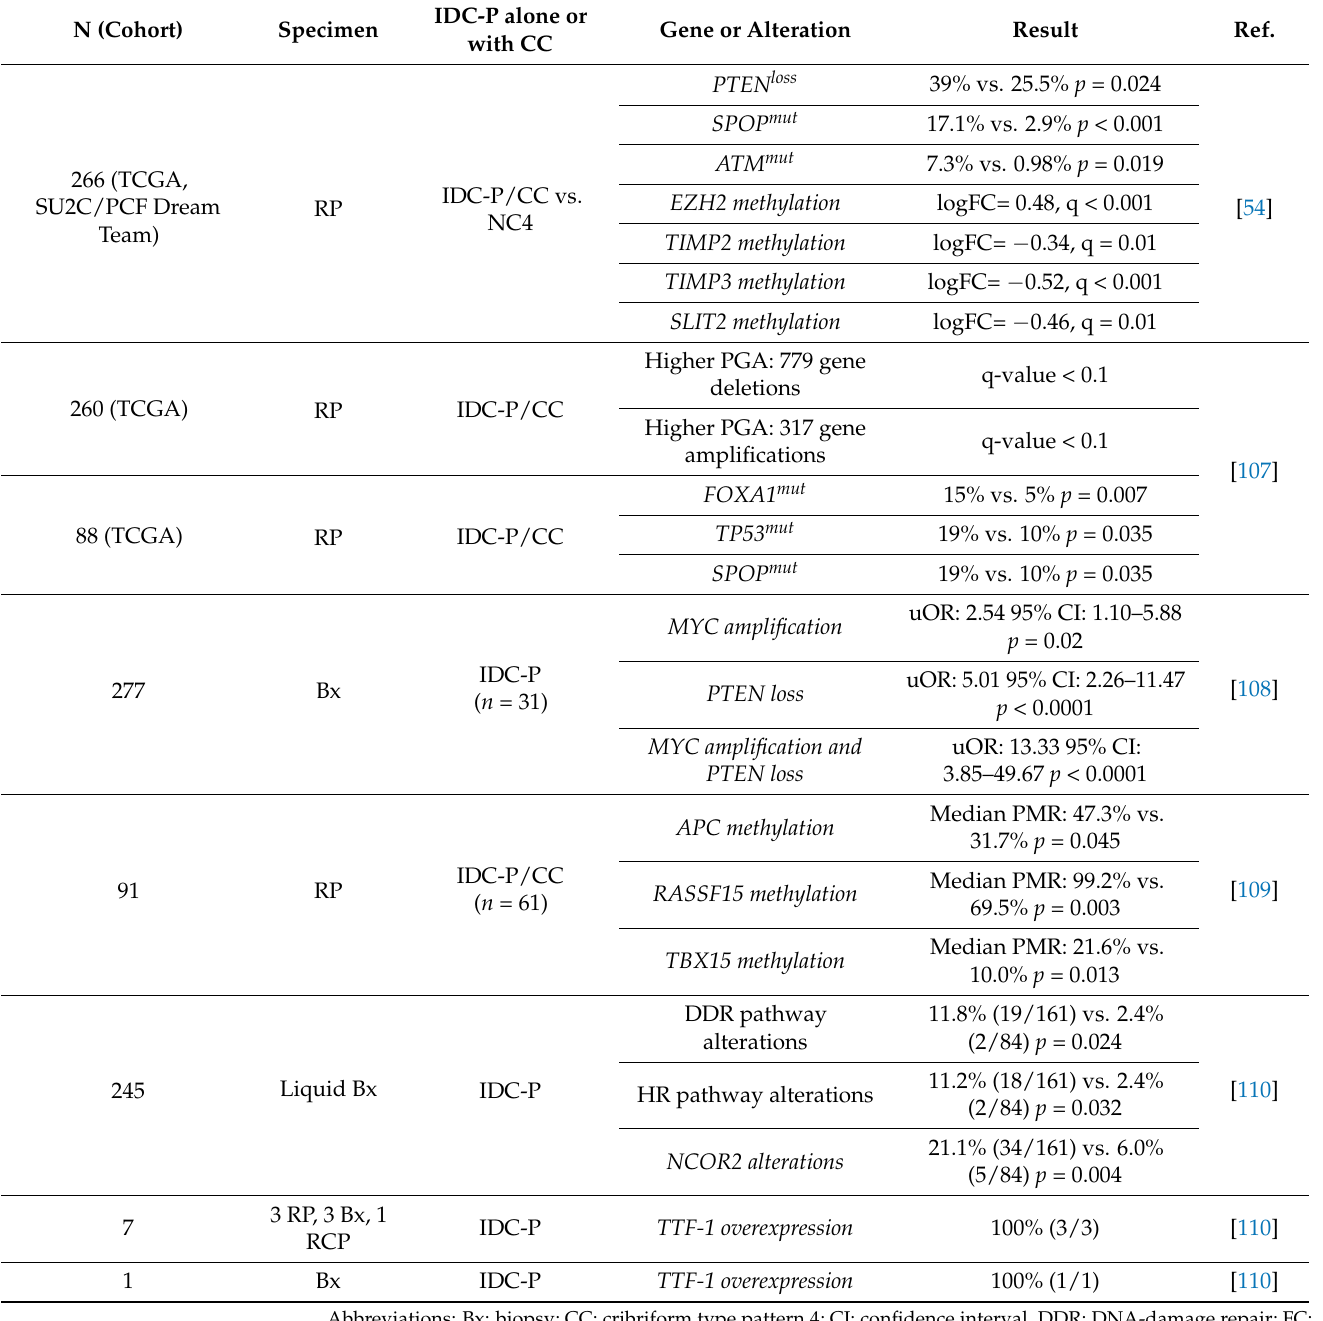
Table 3. Overview of the studies comparing cases with IDC-P alone or in combination to cases without IDC-P. For in silico studies, selected results are